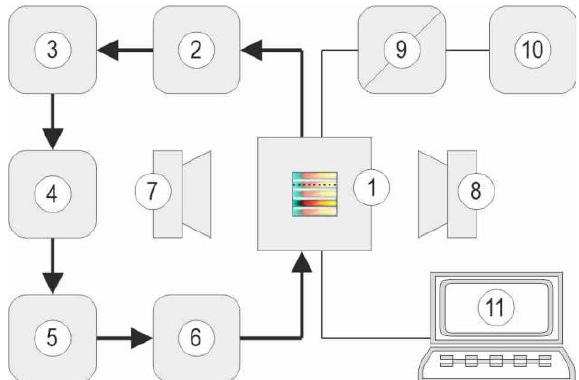
Figure 1. Block diagram of the main loops and systems realized on the experimental rig: (1) test section with mini-channels, (2) heat exchanger, (3) compensating tank, (4) filter, (5) circulating pump, (6) mass flow meter, (7) infrared camera, (8) high speed camera, (9) ammeter and voltmeter, (10) power supply, (11) data acquisition stations and PC computer.